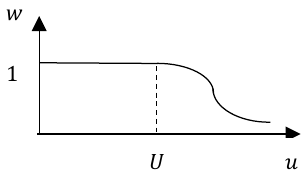
𝑢𝑢 𝑈𝑈 Figure 6. Modification